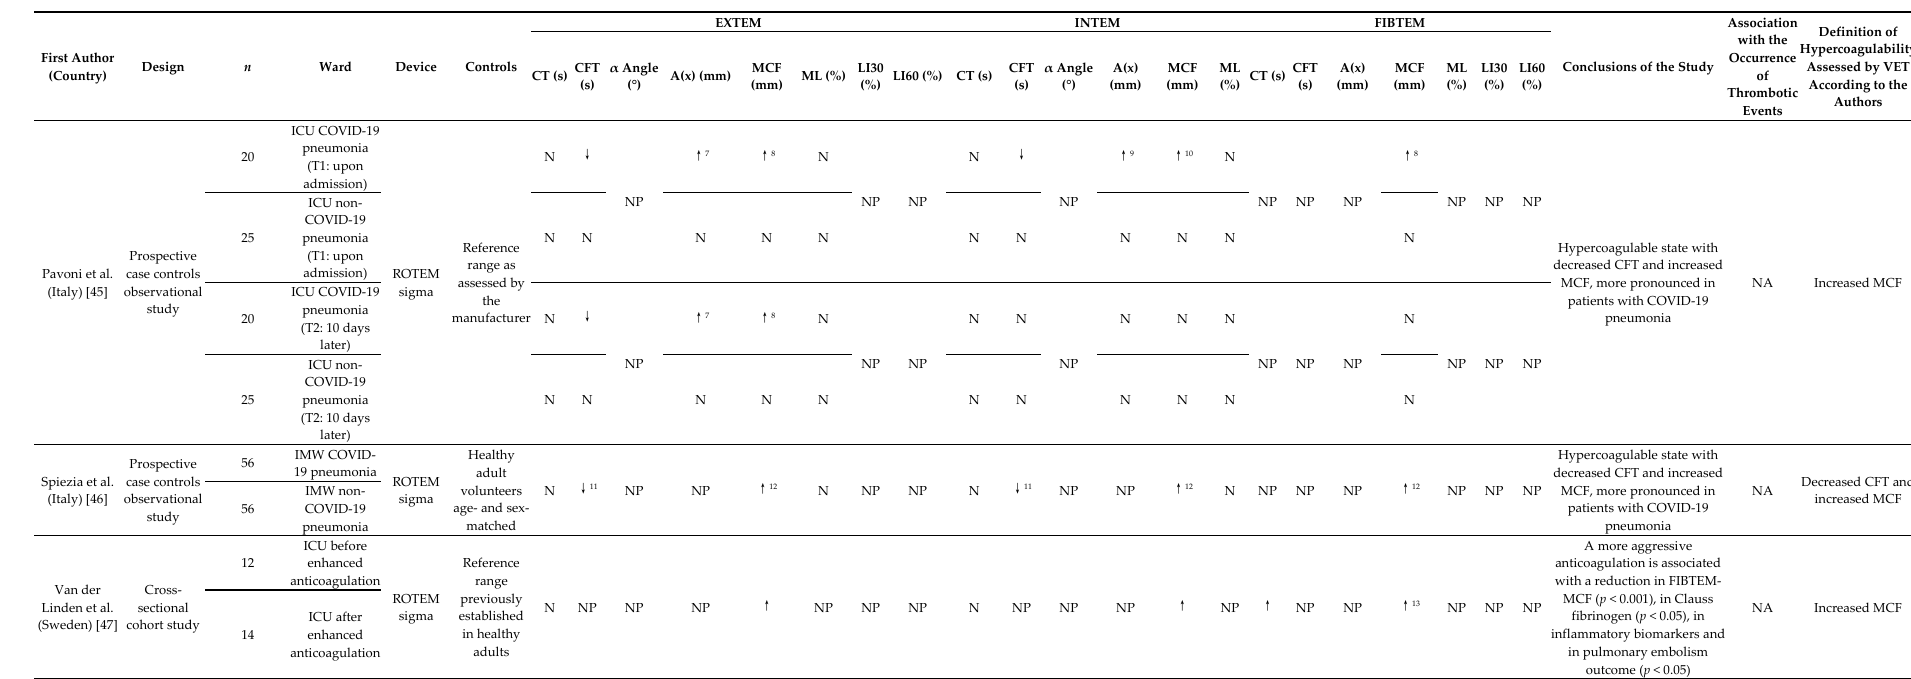
Table 5. Main findings of studies reporting ROTEM results (except APTEM and TEM-tPA